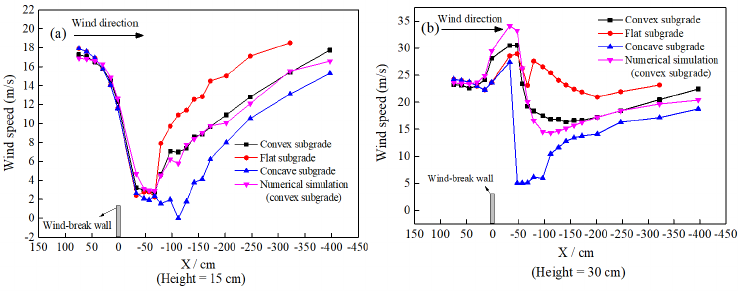
Figure 7. Wind speeds around three wind-break walls ( u ∗ = 0.9701 m/s), and the measuring heights are: ( a ) 15 cm and ( b ) 30 cm.